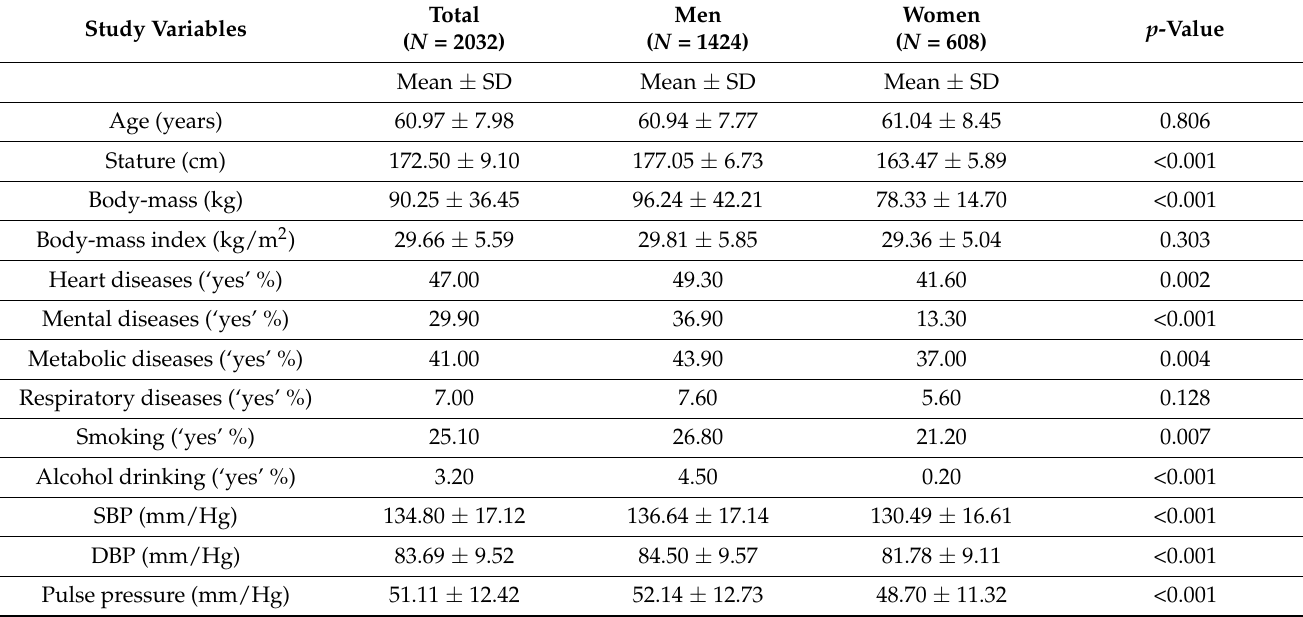
Table 1. Basic descriptive statistics of the study participants ( N =